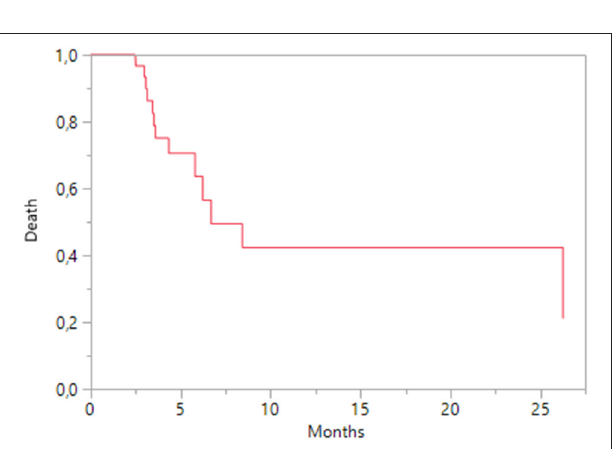
FIGURE 4 | Kaplan-Meier estimates of Overall Survival on everolimus